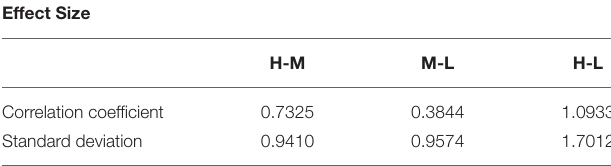
TABLE 3 | Effect size of different comparison